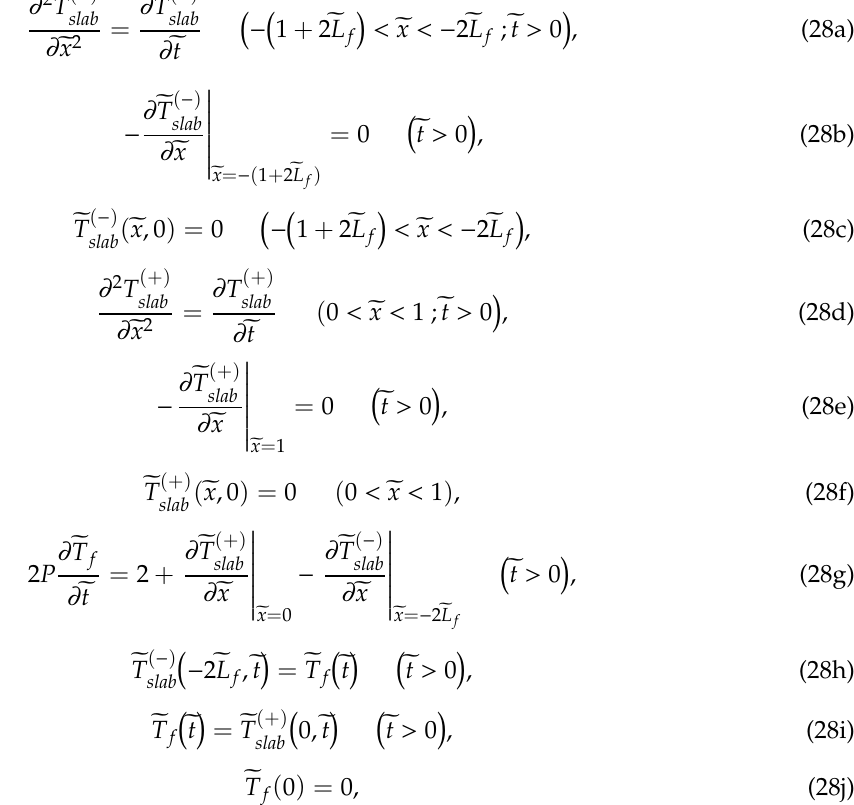
f as thickness, in perfect contact with two